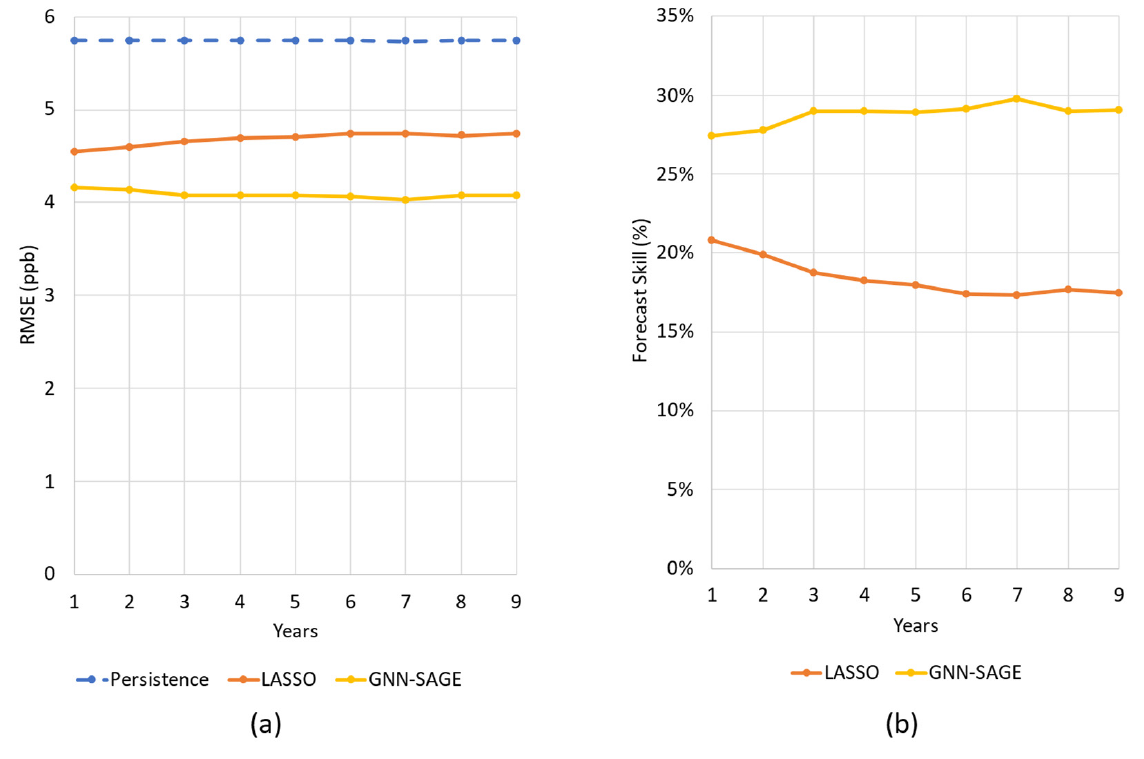
Figure 5. Influence of different sizes for the training dataset for GraphSAGE model compared with benchmarking models LASSO and persistence in terms of RMSE ( a ) and Forecast Skill ( b ).